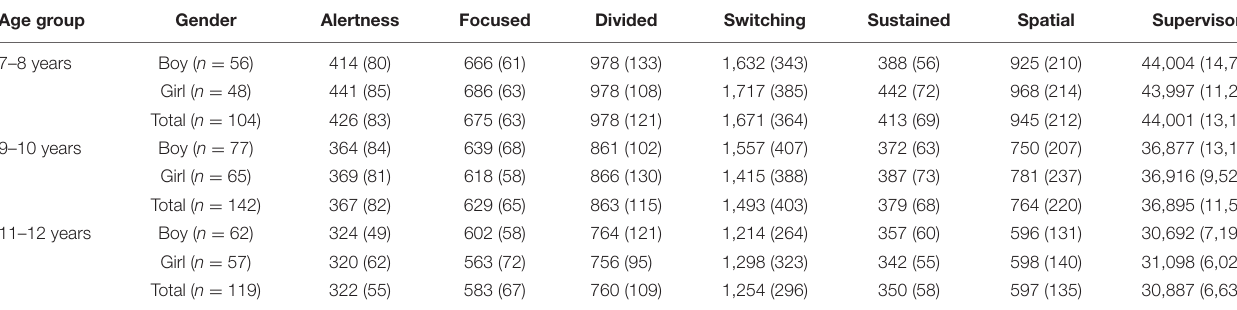
TABLE 3 | Reaction times in the seven tasks across the three groups.